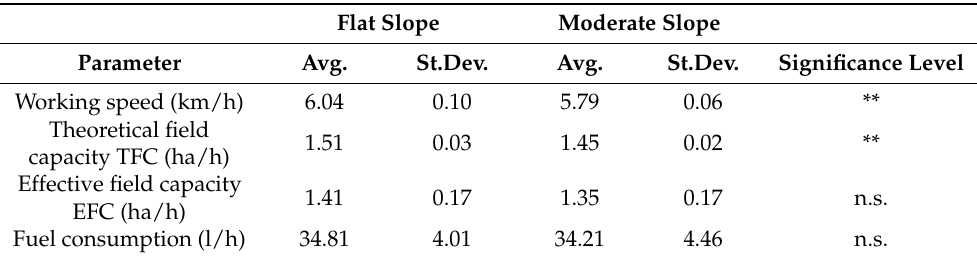
Table 5. Results of working performance analysis. “**” indicates statistically significant difference at p < 0.01. Flat Slope Moderate Slope Parameter Avg. St.Dev. Avg. St.Dev. Significance Level Working speed (km/h)